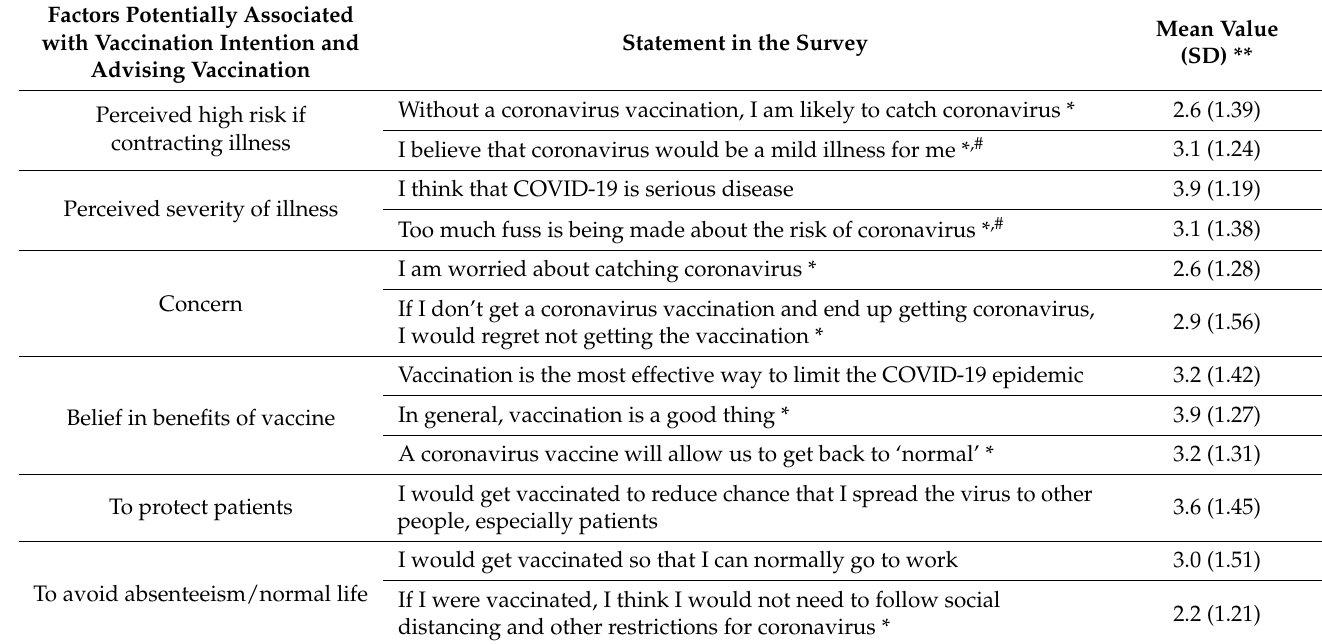
Table A1. Statements for evaluation of different factors potentially associated with vaccination intention and advising vaccination. Factors Potentially Associated with Vaccination Intention